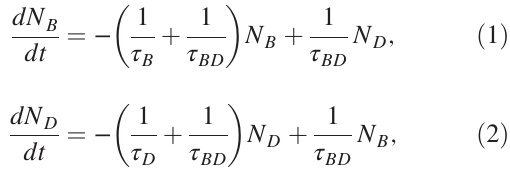
(open circles). The broken line is the fit with Eq. (5). D . In (b) and (c), data points for BD